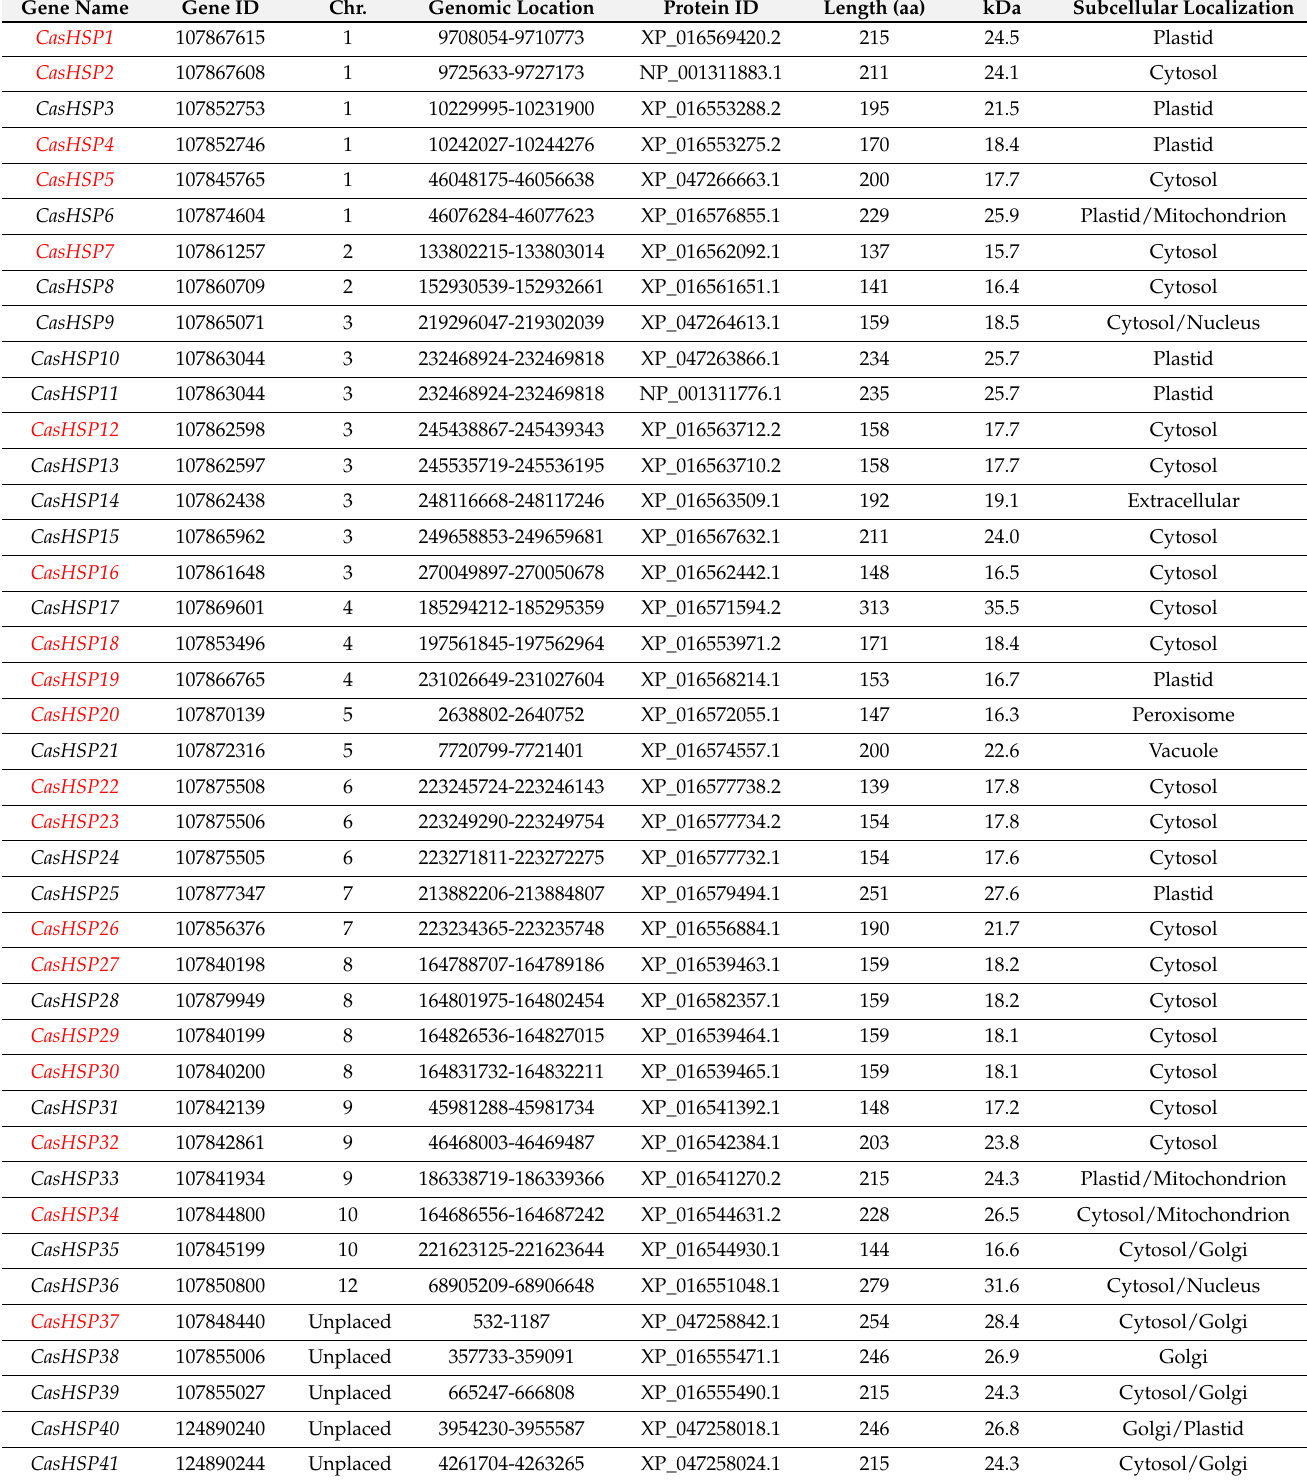
Table 1. Summary of the 41 small heat shock proteins ( sHSPs ) genes identified in the pepper ( Capsicum annuum L.) genome and some of the properties related to the protein encoded for these genes and their subcellular localization. The nineteen CasHSP genes specifically detected in the sweet pepper fruit transcriptome are highlighted in